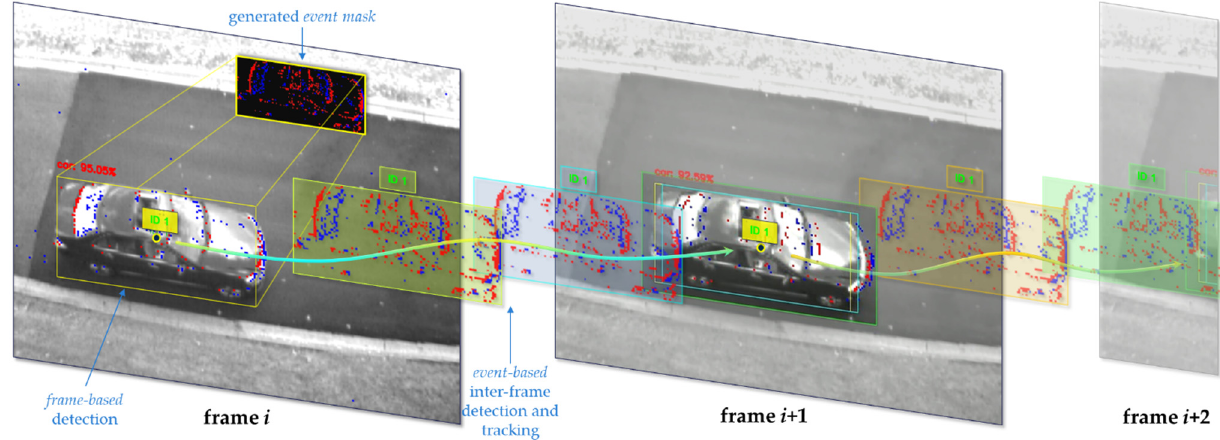
Figure 1. A conceptual diagram of our high-temporal-resolution object detection and tracking ap- proach using images and event data. The figure shows three sequential grayscale image frames across time, with events (red and blue dots) overlayed on top, representing their sparse and asynchronous nature. An event mask is extracted whenever an object is detected in a given image, which is then used for inter-frame detection and tracking using events until a new image is captured and the process is repeated.